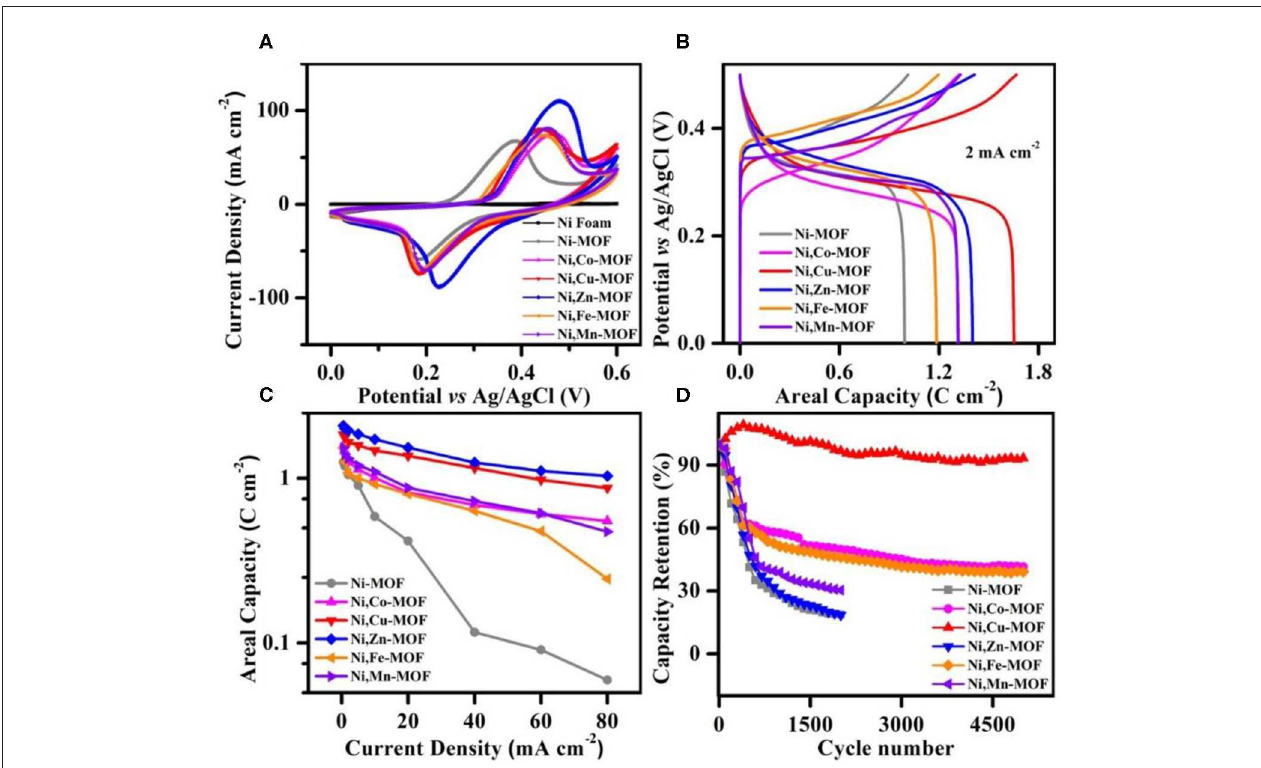
FIGURE 4 | (A) CV curves of the Ni foam, Ni-MOF, Ni,Co-MOF, Ni,Cu-MOF, Ni,Zn-MOF, Ni,Fe-MOF, and Ni,Mn-MOF, respectively. (B) Charge–discharge curves at 2mA cm − 2 . (C) Rate performance of all samples. (D) Cycling performance collected for 2,500